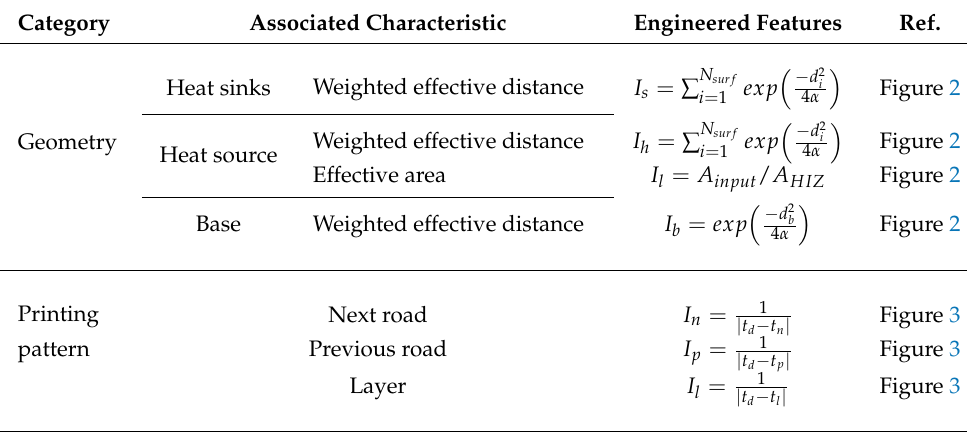
Table 2. List of the final features with the formulae provided and the link to reference figure depicting the corresponding